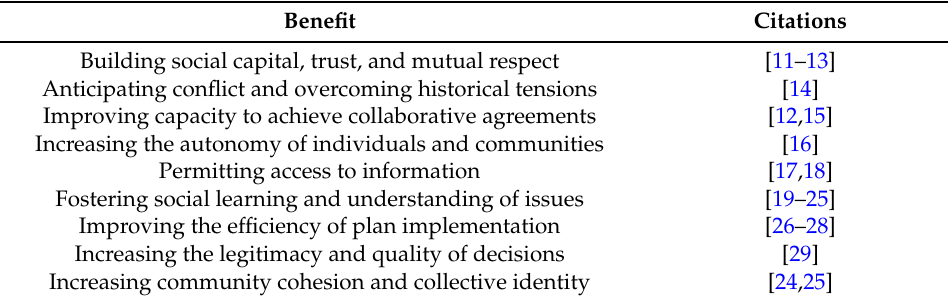
Table 1. Benefits of public